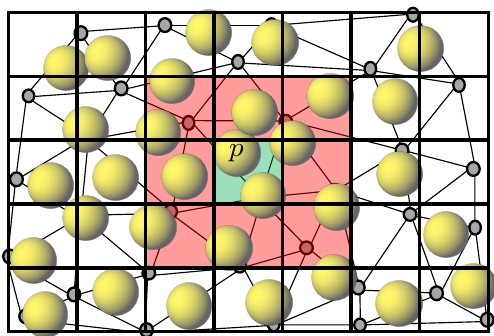
Figure 5. Linked-cell method. : mesh nodes. : superimposed Cartesian grid. The particle of interest is noted p in the central cell ( ). The particles of which center belongs to this cell or one of the surrounding ones ( ) are stored as potential collision partners of particle p .